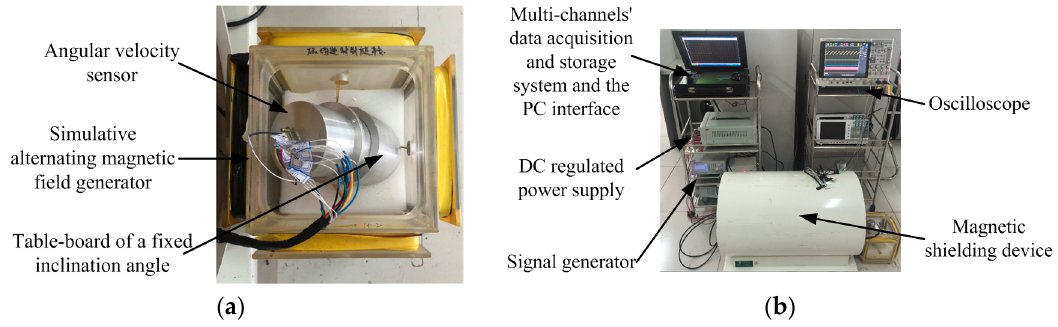
Figure 7. Experimental test platform of the simulative alternating magnetic field: ( a ) Simulative magnetic field generator; ( b ) Experimental test platform.